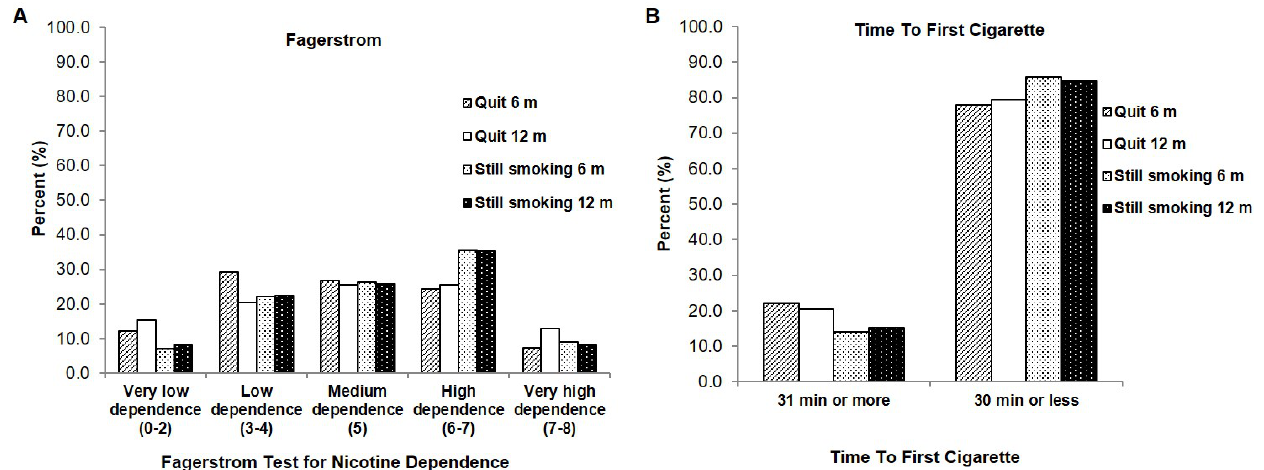
Figure 4. Comparison of smoking variables between those who were smoking and then quit, and those who continued to smoke at 6 months and 12 months ( A ) Fagerstrom Test of Nicotine Depen- dence ( B ) Time to First